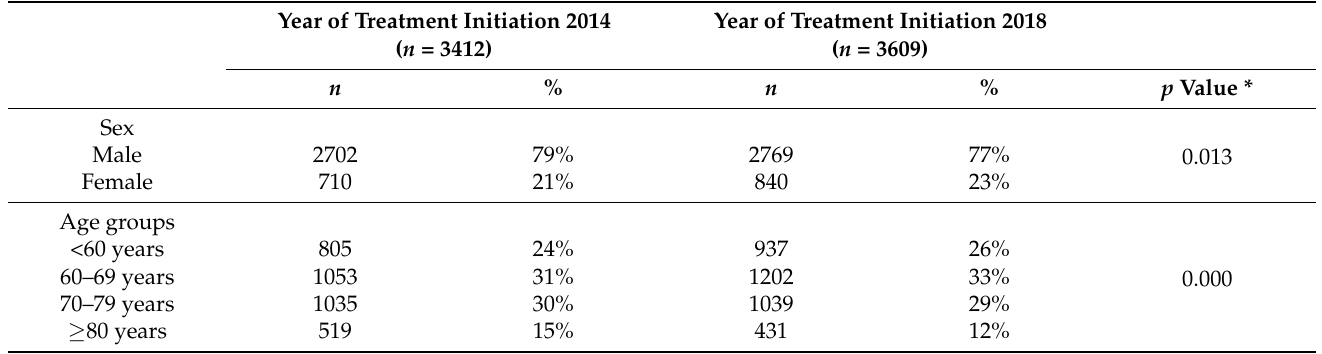
Table 1. Characteristics of patients diagnosed with malignant neoplasm of the lung, 2014 versus